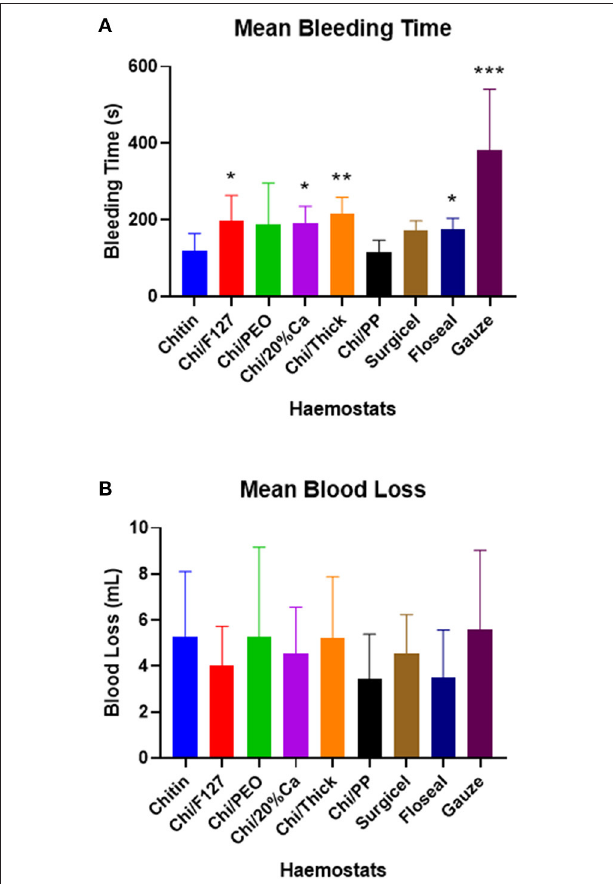
FIGURE 4 | (A) The mean bleeding time and (B) the mean blood loss, with rat femoral arterial injury experiment. * p < 0.05, ** p < 0.001, compared to chitin and *** p < 0.05 compared to chitin (modified and non-modified), Surgicel and FloSeal, analysed by Kruskal-Wallis one-way ANOVA with Dunn’s test.